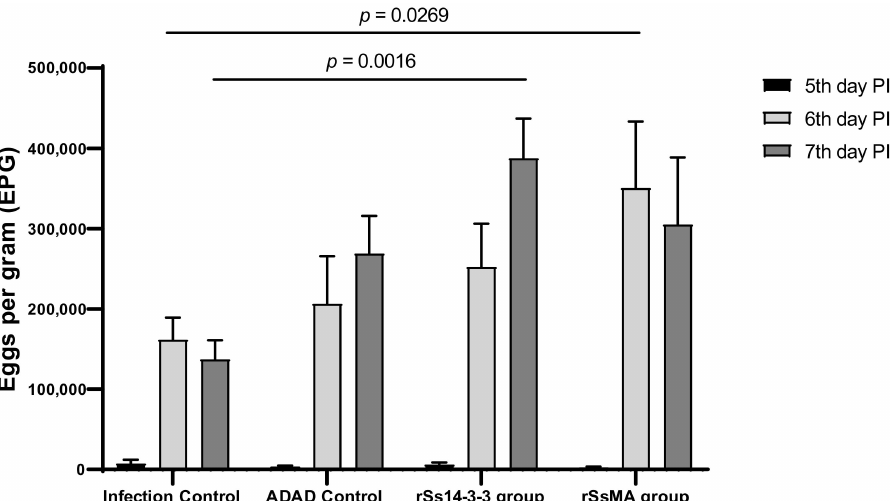
Figure 2. Number of eggs per gram (EPG) in mice feces after immunization with rSs14-3-3 and rSsMA formulated in ADAD vaccination system and challenged with 3000 S. venezuelensis L3 determined at 5, 6, and 7 days post-infection (PI). Bars represent means ± SEM. Differences between groups were determined by two-way ANOVA F (3,84) = 4.18; p = 0.0083. Post-hoc Tukey’s honestly significant difference (HSD) test p -values are shown in the graph.